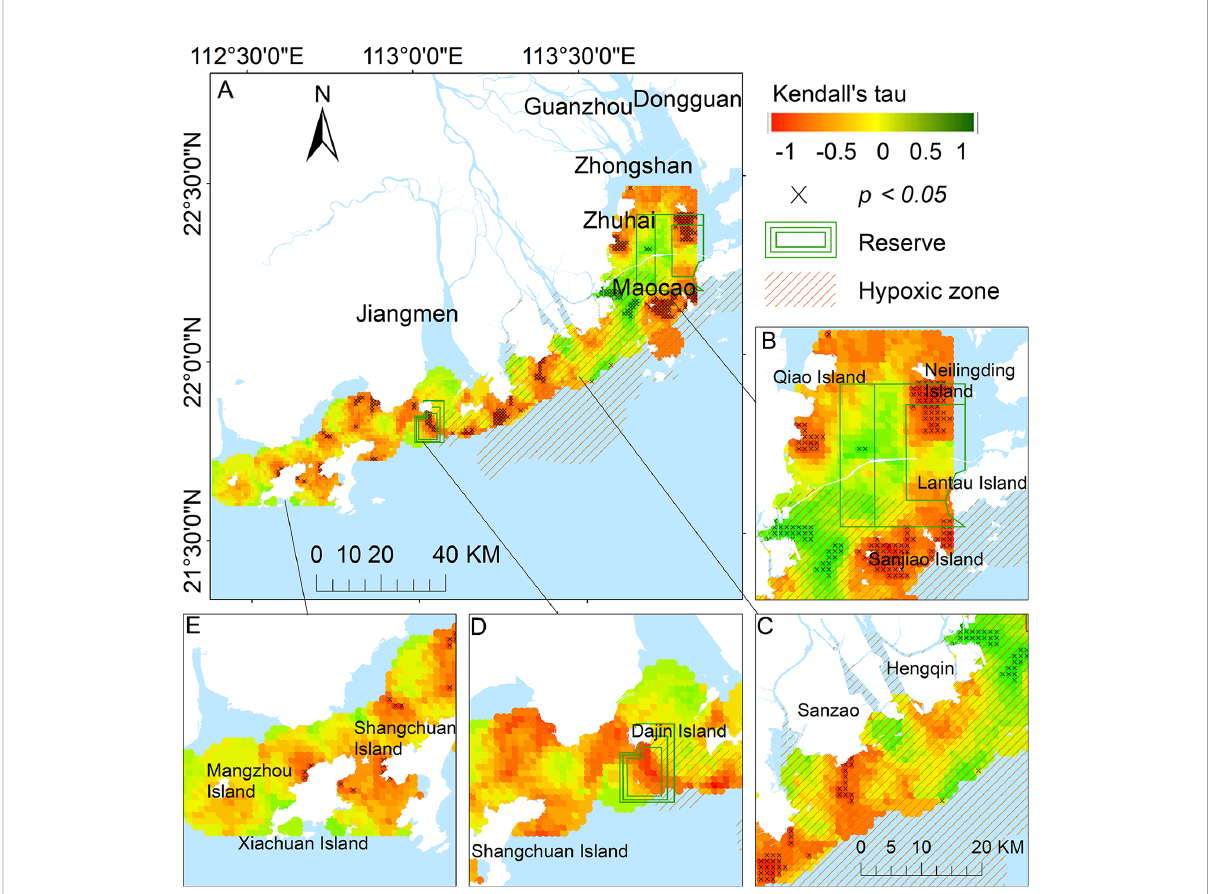
FIGURE 3 Spatial distribution pattern changes of sighting rates (sightings/surveys/km 2 ) of Indo-Paci fi c humpback dolphins using Kendall ’ s tau correlation coef fi cients of sighting rates (increased: Kendall ’ stau>0; decreased: Kendall'stau<0; ×: p<0.05 signi fi cance level) with year for each cell in the Pearl River Estuary (PRE; 2015-2021). Current reserve area (green boxes); hypoxic zone (orange shaded area); (A) entire PRE; (B) eastern PRE; (C) middle PRE; (D) Dajin and Shangchuan Islands in western PRE; (E) Shangchuan, Xiachuan, and Mangzhou Islands in western